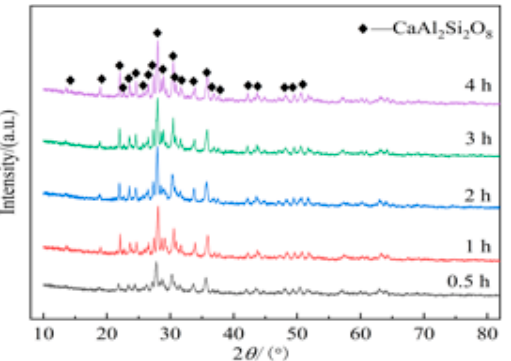
Figure 10. XRD patterns of microcrystalline glass product samples prepared at different crystalliza- tion times.